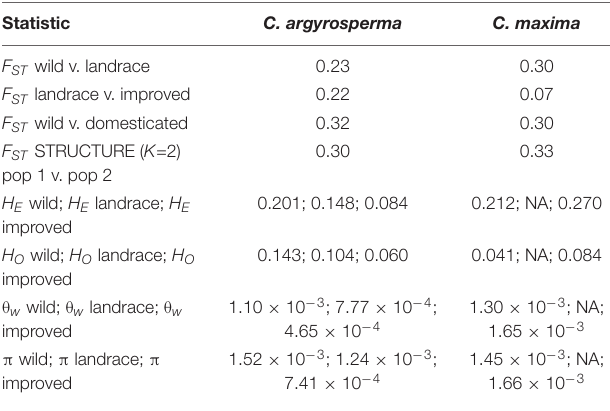
TABLE 2 | Summary of genetic diversity